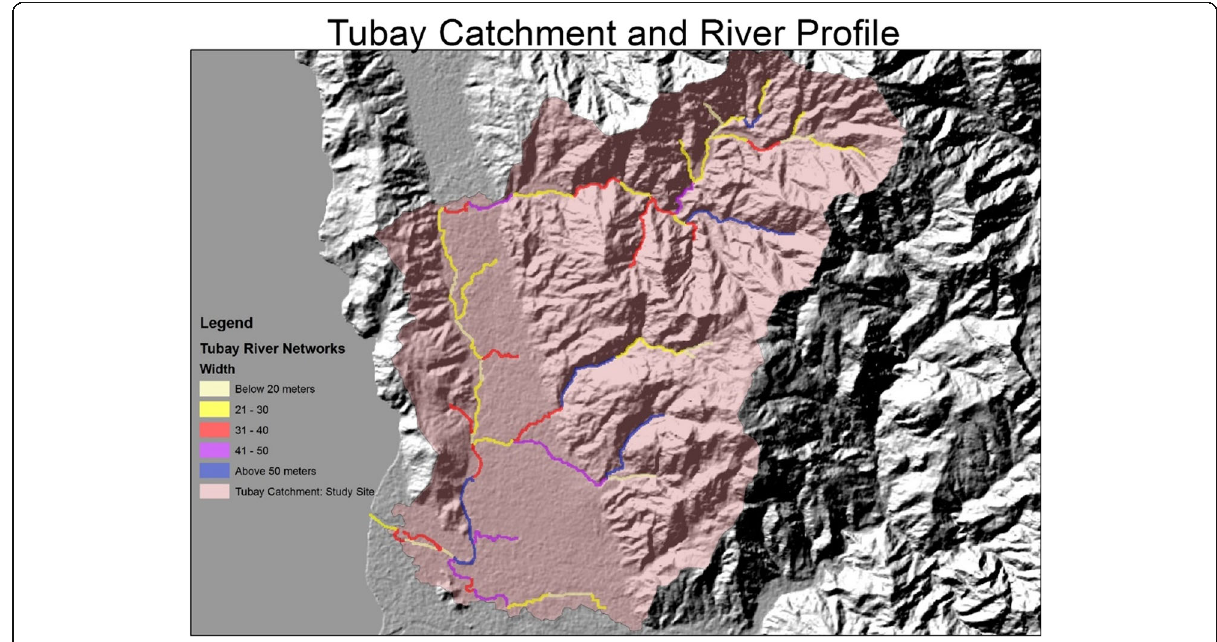
Fig. 3 Map showing the derived river widths from analyzing Landsat 8 OLI and bathymetric